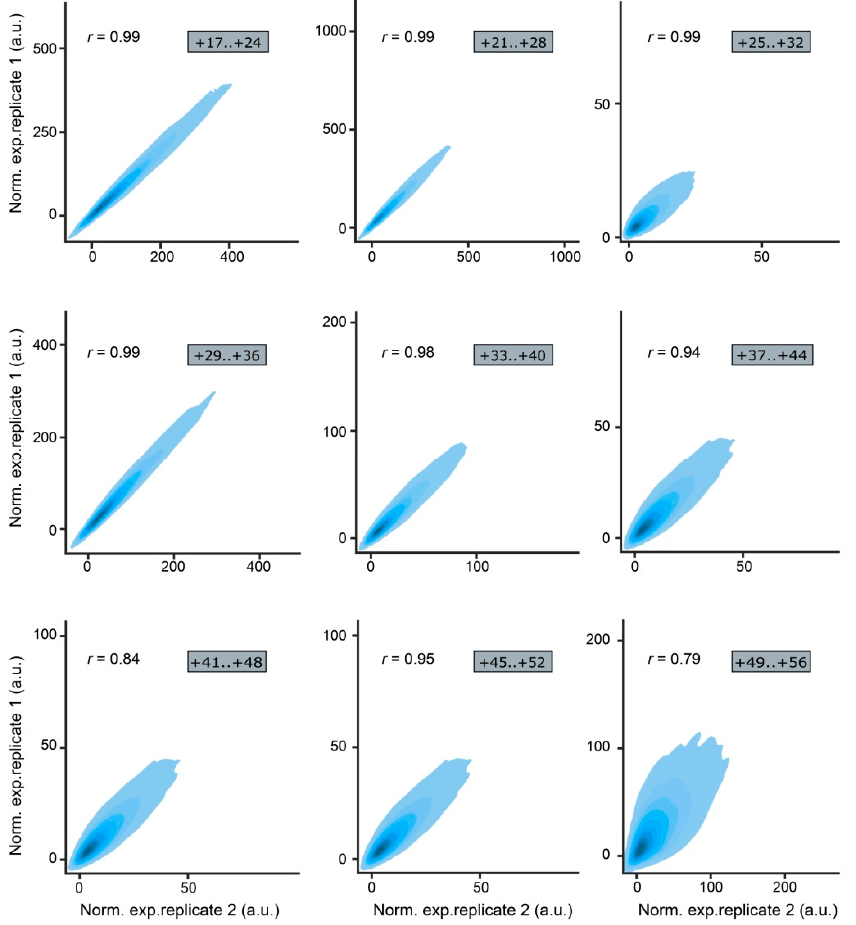
Figure 3. Correlation of normalized expression values between the replicates of the MPRA libraries visualized as density scatterplots; r denotes Pearson’s correlation coefficient.